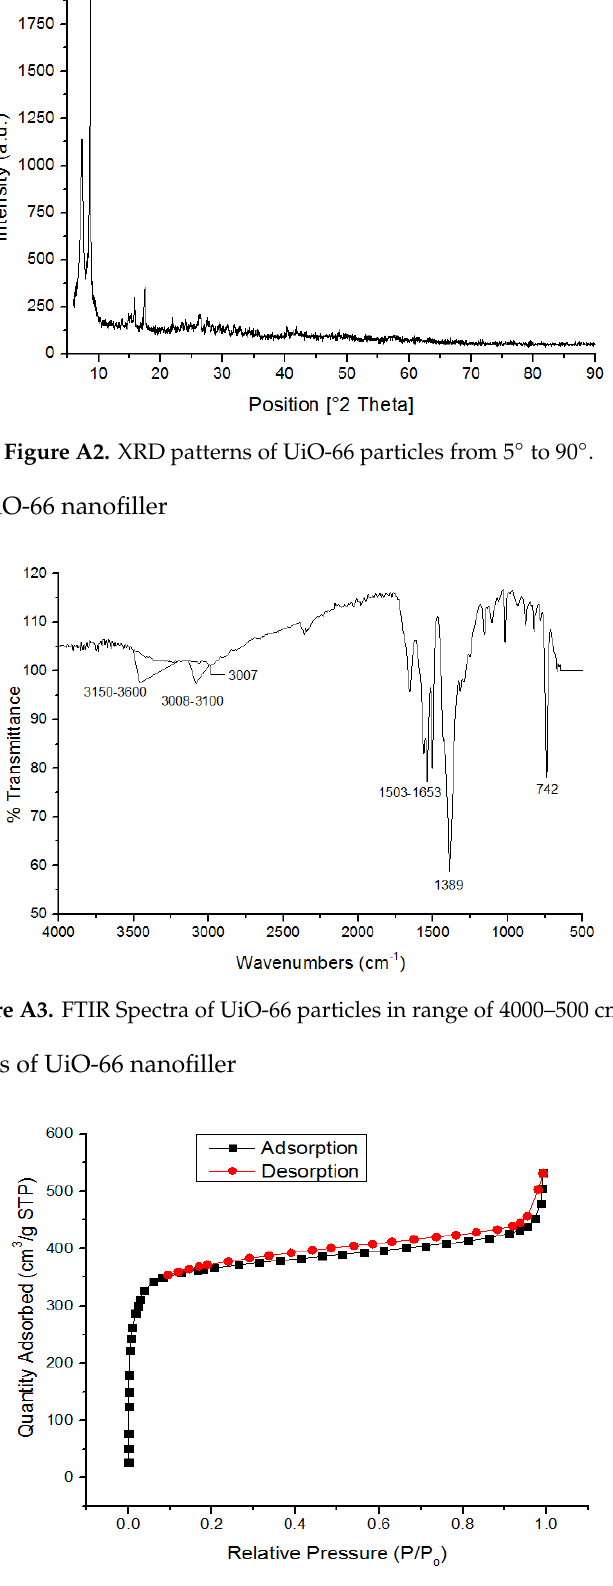
Figure A4. Nitrogen isotherm sorption plot of UiO-66.